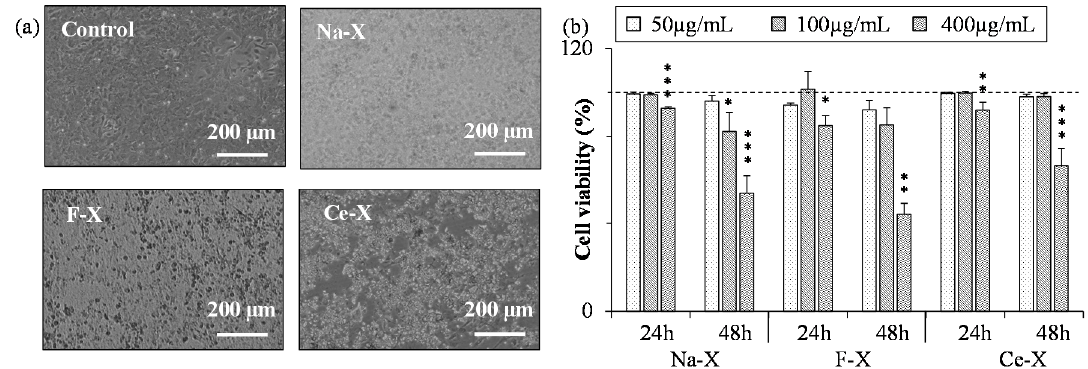
Figure 10. ( a ) Representative photographs (phase contrast) of astrocytes after 48 h exposure to 400 µg/mL of as-synthesized Na-X, fluorinated F-X, the cerium ion exchanged Ce-X zeolites, and a control sample (H 2 O); ( b ) Quantification of astrocytes viability after 24 h and 48 h exposure to Na-X, F-X, and Ce-X zeolites with different concentrations. Cell viability was assessed using the WST-1 test. Mean ± SD. n = 3; HSD Tuckey post-hoc test after a significant ANOVA (* p < 0.05; ** p < 0.005 ; *** p < 0.0005 vs. control group).